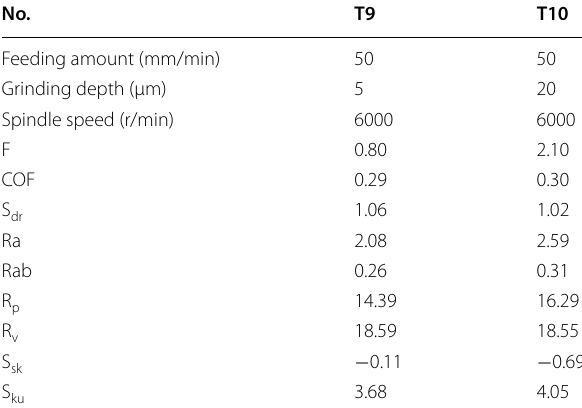
Table 4 Experimental parameters comparison of T9 and